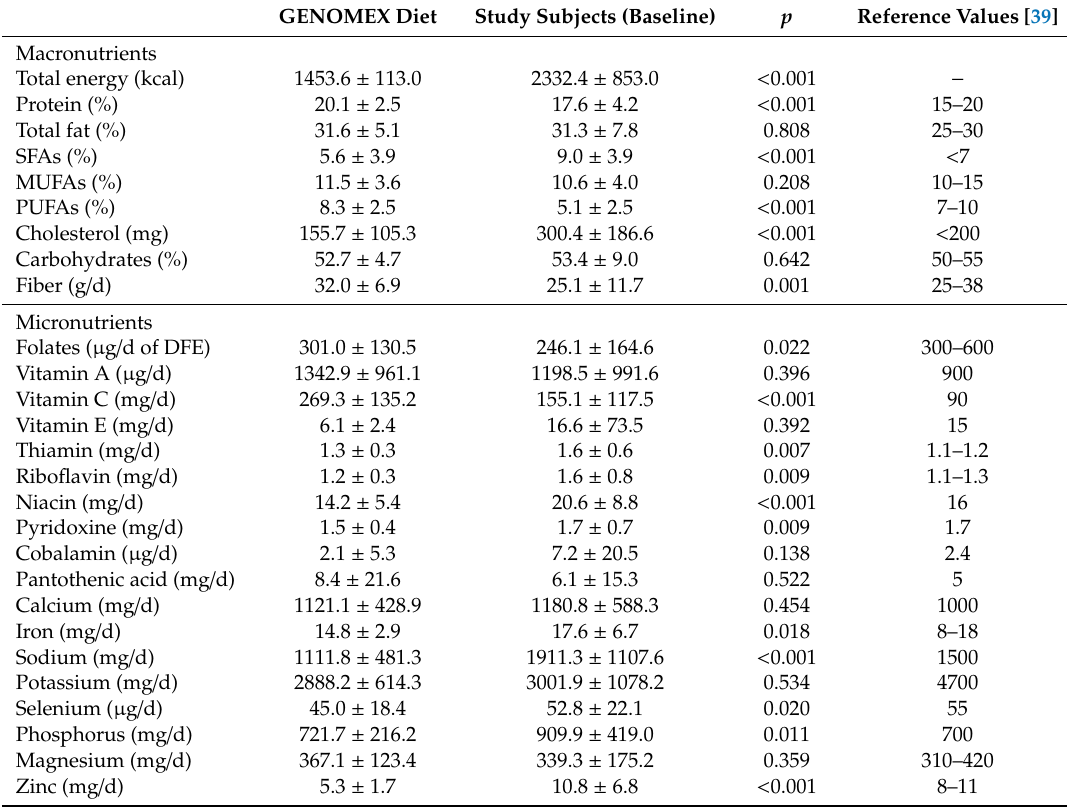
Table 1. Macro and micronutrient distribution of the GENOMEX diet and baseline dietary features of study